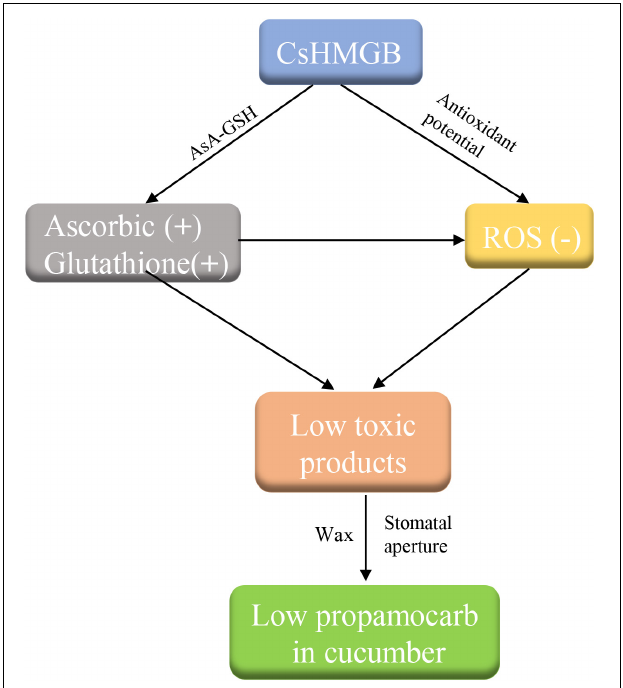
FIGURE 12 | Simple pathway model of propamocarb degradation and metabolism in